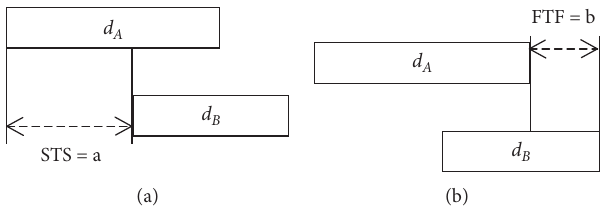
Figure 1: (a) Activities with the STS relationship; (b) the transformation of STS to the FTF relationship.